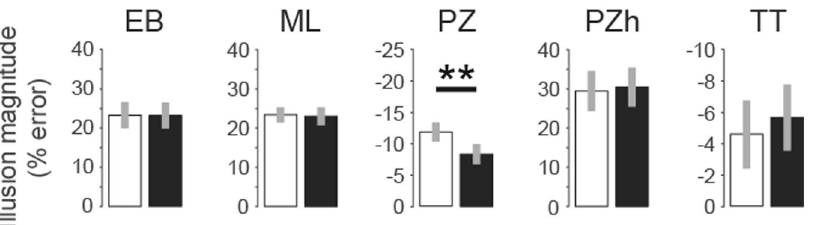
Figure 5. Illusion magnitudes as percentage of error for females (white) and males (black). Illusion magnitudes were calculated as the mean difference between the adjustable target and the reference element. This difference was divided by the reference value and multiplied by 100. For the Tilt illusion, the mean difference between the target item and the reference element was divided by the orientation difference between the surround and the center, i.e, 69 degrees. Thus, one degree corresponds to 1.45% of error. Error bars represent ± 2SE, * p < 0.05, *** p <